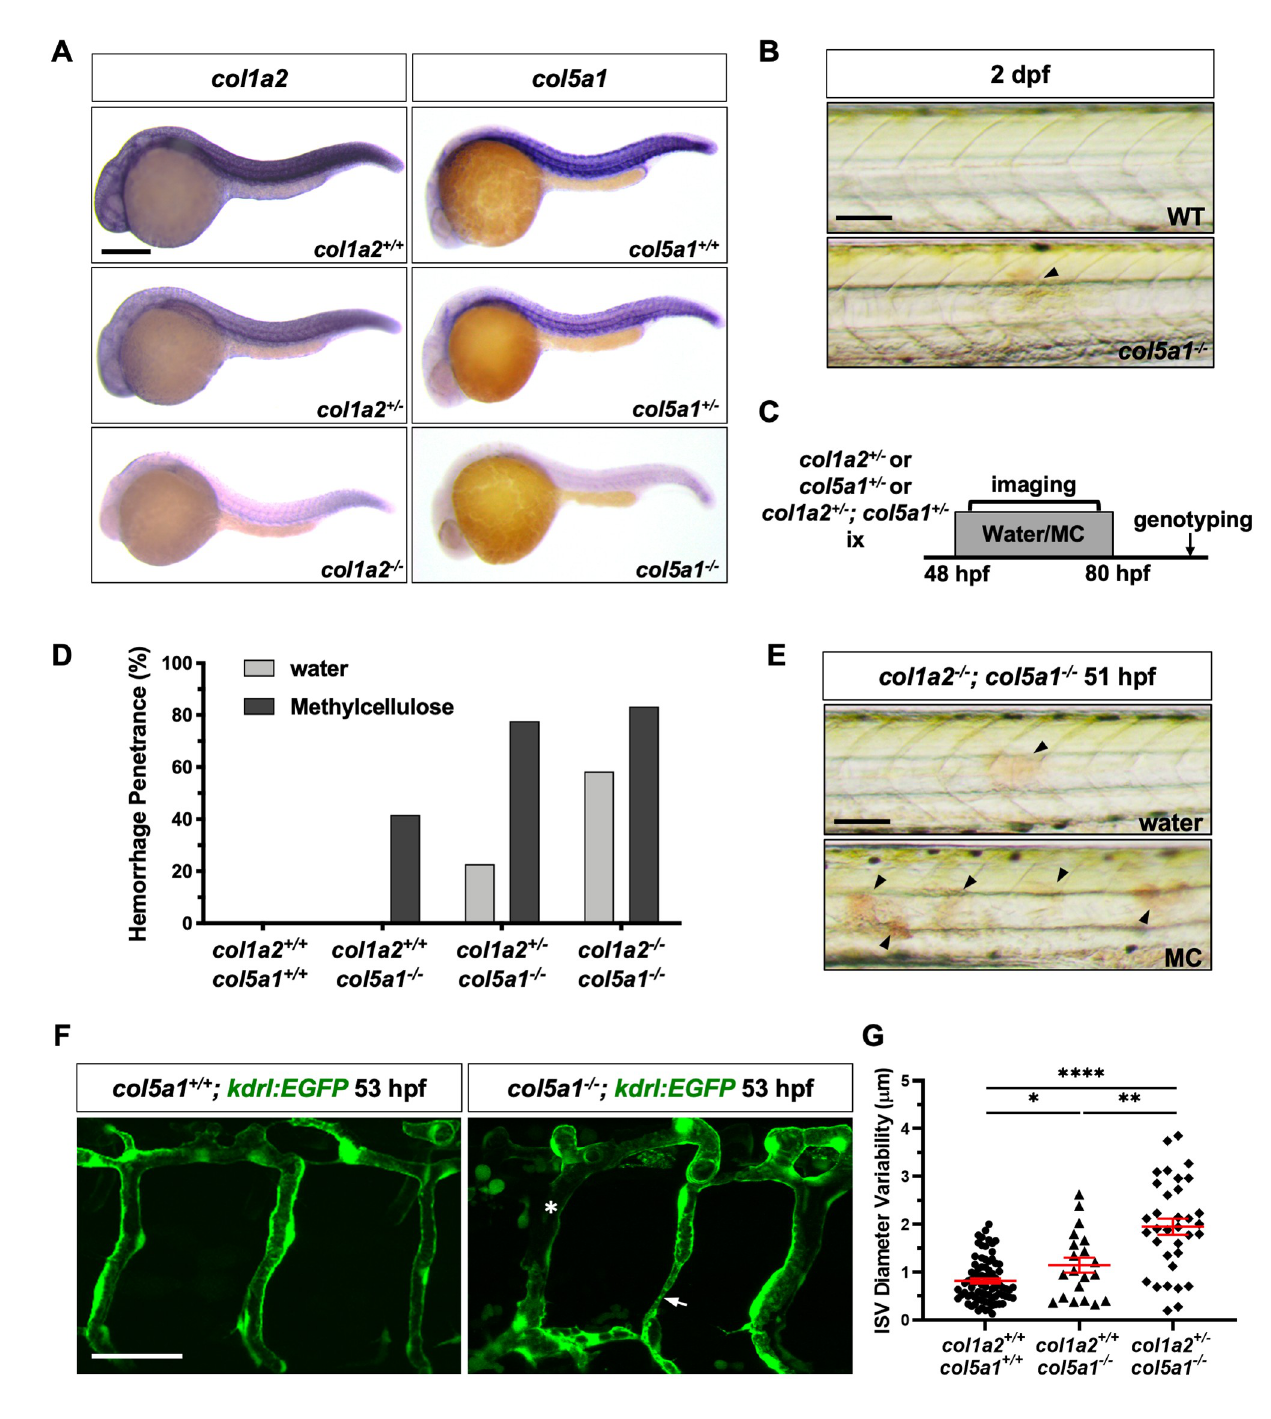
Fig 6. Characterization of collagen mutants. (A) Embryos from intercrosses of col1a2 +/- adults or col5a1 +/- adults were stained at 24 hpf by mRNA in situ hybridization with col1a2 (left) or col5a1 (right) probes, respectively. Compared to wild type siblings, heterozygous mutants showed reduced staining, and homozygous mutants displayed an almost complete loss of staining for both genes examined. n = 30 embryos for each staining. (B) col5a1 -/- mutants but not wild-type siblings showed spontaneous hemorrhage in the trunk (arrowhead) at 2 dpf. (C) Schematic of experimental protocol for phenotypic analysis of collagen mutants. Embryos from intercrosses of 1) col1a2 +/- adults, 2) col5a1 +/- adults, or 3) col1a2 +/- ; col5a1 +/- adults were incubated in either water or 0.6% methylcellulose (MC) and screened for the hemorrhage phenotype in the trunk from 48 to 80 hpf. All embryos were subsequently genotyped. (D)